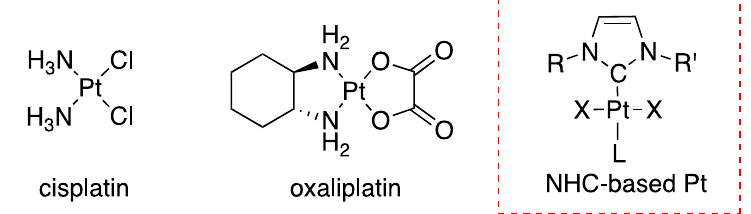
Figure 1. Chemical structures of platinum complexes cisplatin, oxaliplatin and N-heterocyclic carbene platinum (II) complexes that showed high cytotoxic activities against cancer cells.